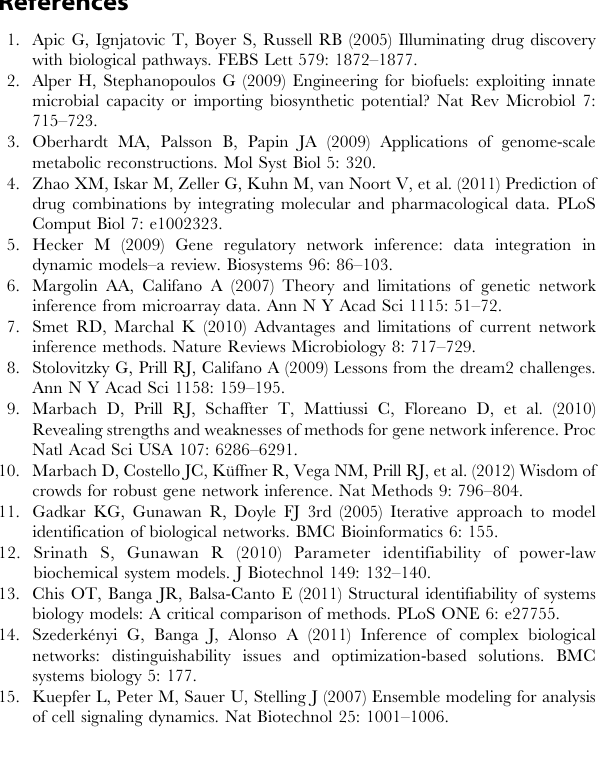
Table S2 Performance of TRaCE on inference of E. coli Figure S2 Example of an ensemble involving GRN with Þ of any two digraphs A and B denote the cycle. Consider a GRN consisting of genes A, B and C, all of structural Hamming distance between which are involved in a directed cycle. Further, let us assume that the edge C ? A belongs to the lower bound and A ? C is not in the the upper bound. In this case, the ensemble comprises the graphs shown in (a)-(d). Figure S3 Type A errors due to an FN. (a) G 6 0 ; (b) (cid:2) GG 6 0 ; (c) (cid:2) GG G ; (e) (cid:2) GG M with an FN at C ? D . In this case, f B g ; (d) f B g f B g ~ (cid:2) GG M G M . (f) (cid:2) GG M with an FN at C ? D and an FP at C ? A (g) f B g f B g f B g with an FN at C ? D and an ConTREx reduction of (f). (h) (cid:2) GG M f B g FP at C ? E (i) ConTREx reduction of (h). See text S4 for details. Figure S4 Type A error due to an FP. G 6 0 and (cid:2) GG 6 0 are shown in Fig. S3 (a) and (b), respectively. (a) (cid:2) GG f C g . In this case, (cid:2) GG M ~ (cid:2) GG ~ (cid:2) GG M G with an FP at B ? D . Here, G M . f C g . (b) f C g f C g f C g f C g Table S1 Performance of TRaCE on inference of E. coli subnetworks ( n ~ 100 genes). The reported values represent the average over 50 subnetworks. Let D A { B ð Þ of any two digraphs A and B denote the structural Hamming distance (SHD)